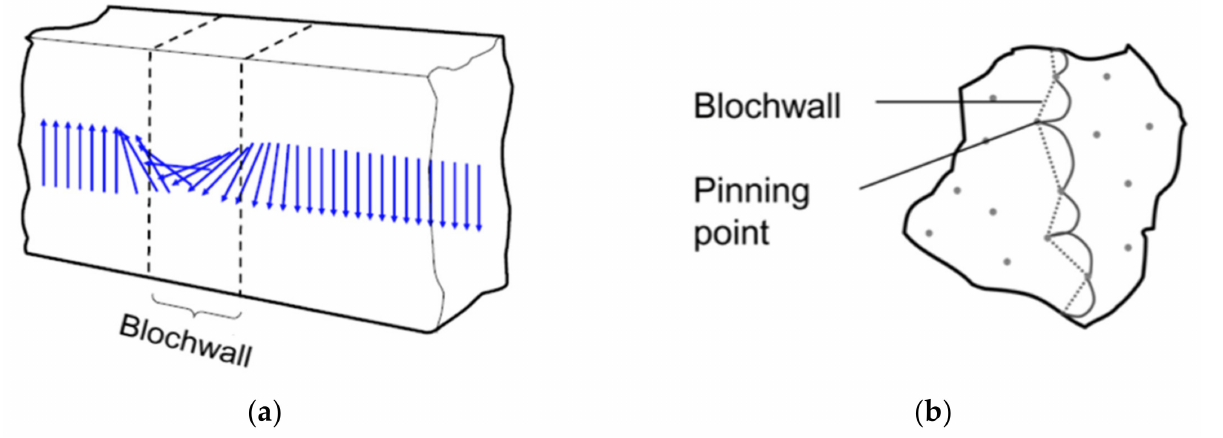
Figure 1. ( a ) 180 ◦ Bloch wall between two differently oriented domains and ( b ) pinned Bloch wall